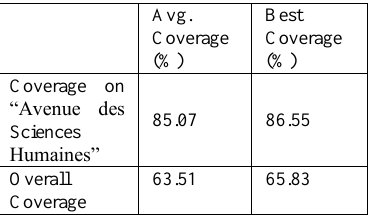
Table 3: Results of Context-Aware algorithm using desirability of coverage in an urban region